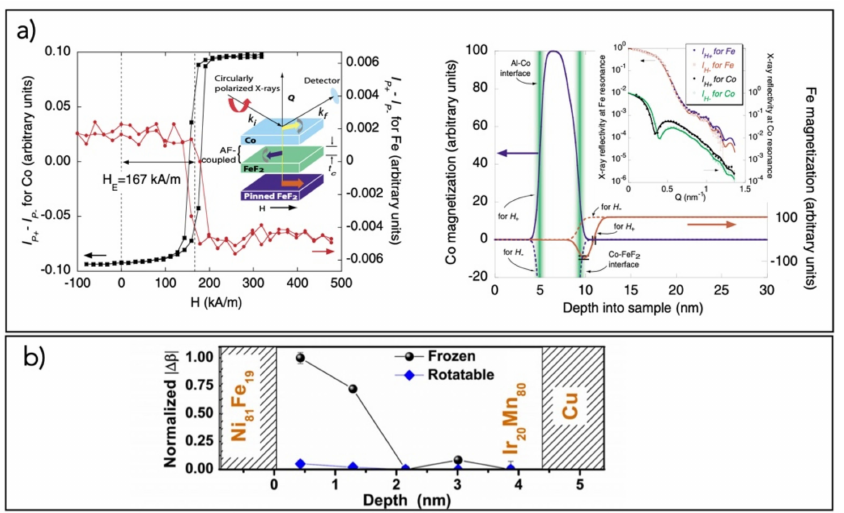
Figure 5. ( a ) Left, hysteresis loops taken at Q = 0.49 and 0.38 nm − 1 for Co (squares) and Fe (red dots), respectively, on the Co/FeF 2 system: clear evidence of exchange bias is present; inset, representations of the X–ray experiment and sample structure; right, spin density depth profiles for Co (blue) and Fe (red) obtained by specular X–ray reflectivity (inset) at H ± = ± 796 kA/m (reprinted figure with permission from [77]. Copyright (2005) by the American Physical Society); ( b ) depth dependence of the frozen and rotating AF (Mn) uncompensated spins in a NiFe/IrMn exchange–biased bilayer (reprinted figure with permission from [85]. Copyright (2010) by the American Physical